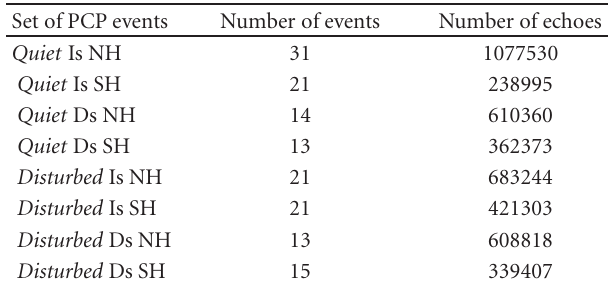
Table 2: An overview of the echoes statistics for the di ff erent subsets of the events used for the PCP analysis. Is and Ds stand for Increases and Decreases of solar wind dynamic pressure, NH and SH stand for Northern and Southern